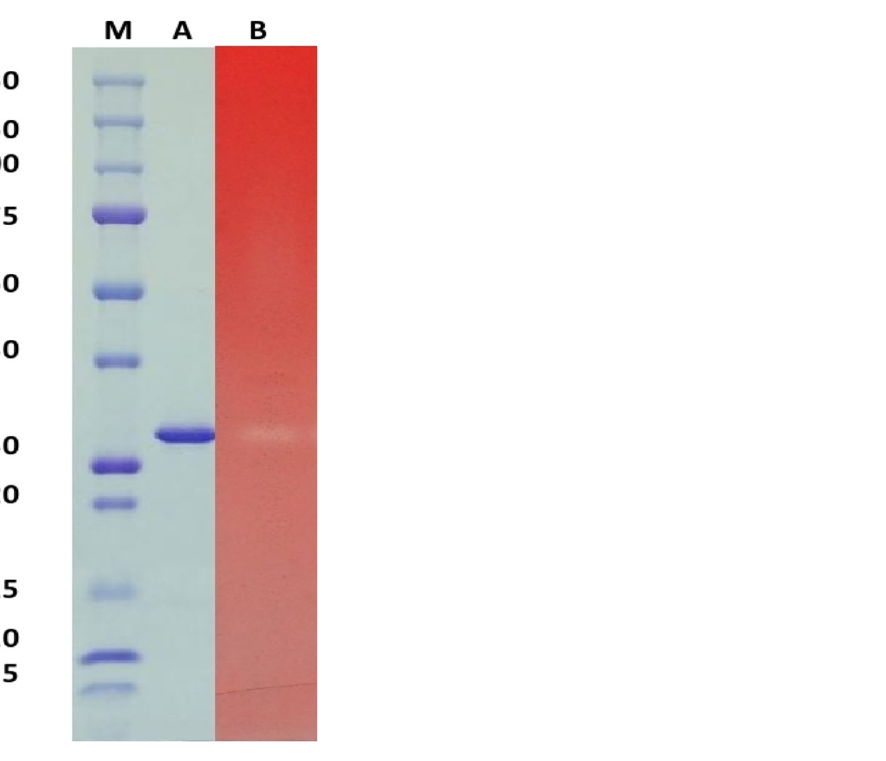
Figure 1. Cropped SDS-PAGE and zymogram of xylanase enzyme produced by Paecilomyces variotti . Lane M: Standard protein marker (250, 150, 100, 75, 50, 40, 30, 20, 15, 10, 5). Lane A: SDS-PAGE of the partially